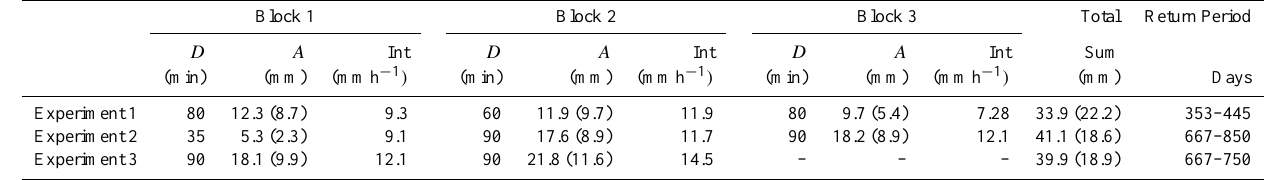
Table 1. Summary of irrigation for each experiment, duration ( D ), amount ( A ), and intensity (Int) for every irrigation block. Also the return period (based on 24h) based on the empirical and a fitted cumulative distribution function. Standard deviation is given for the precipitation sums in brackets. Block 1 Block 2